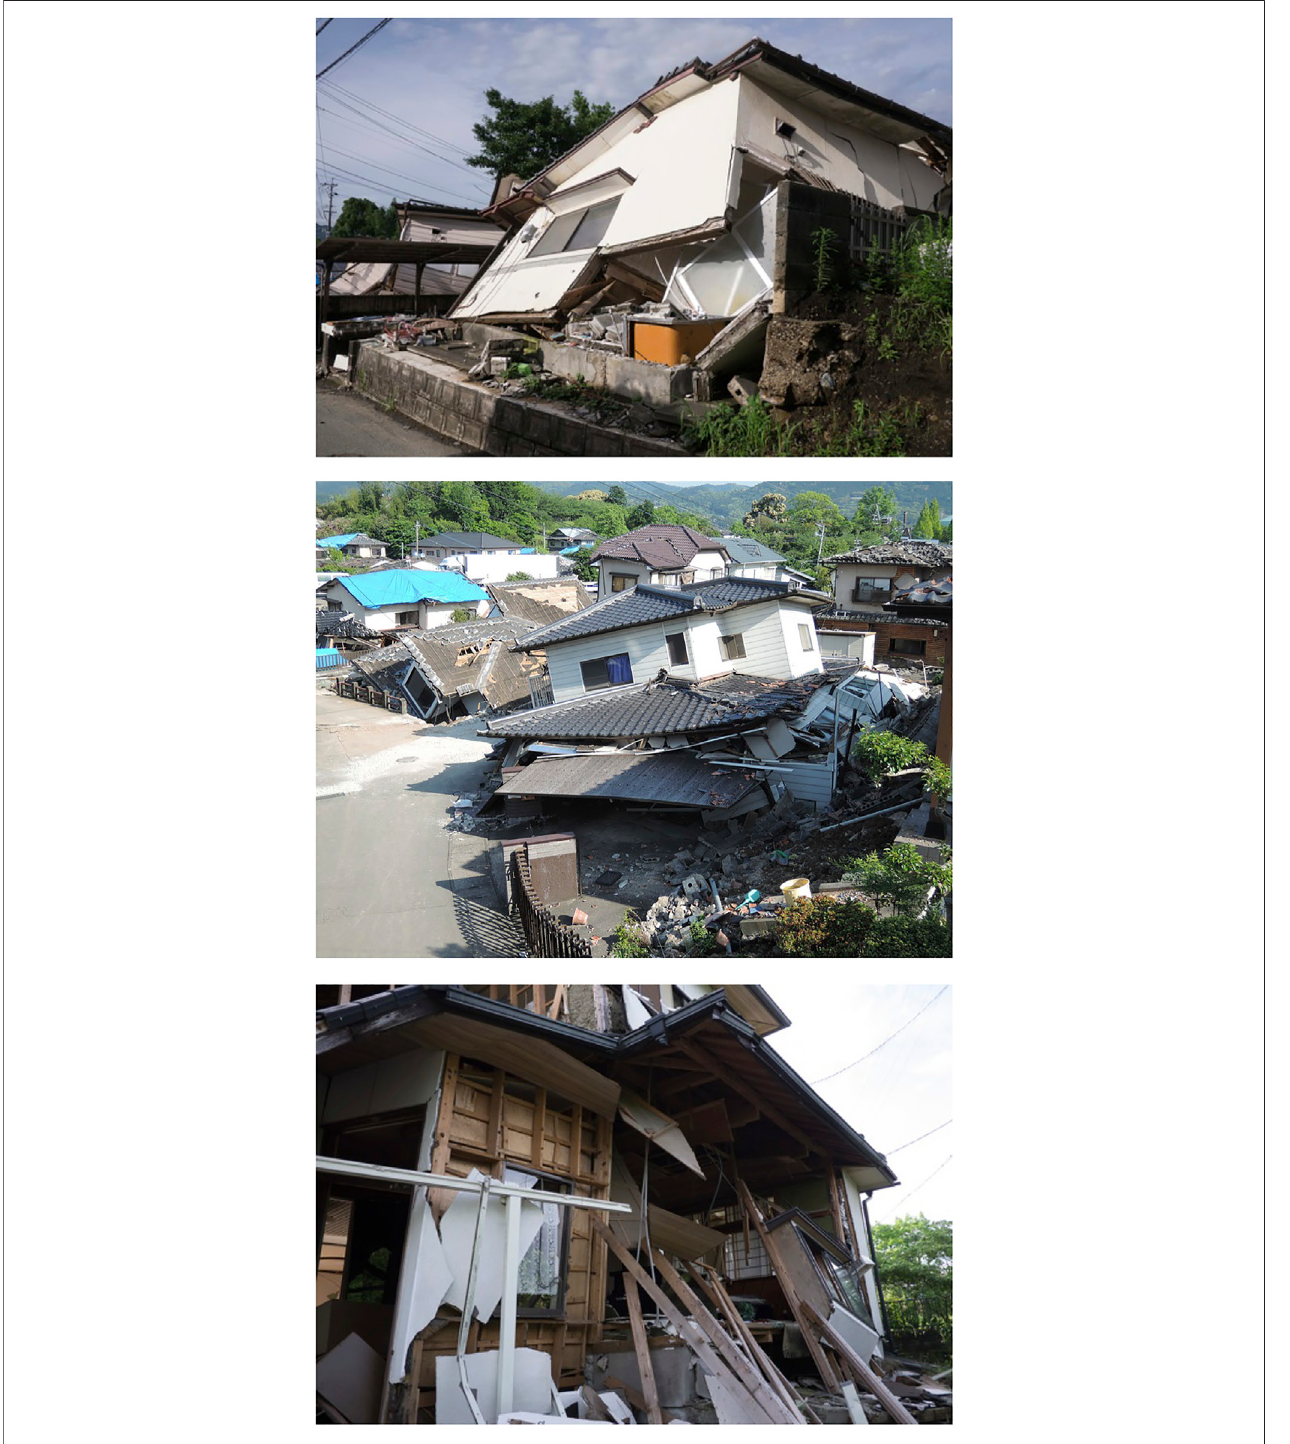
FIGURE 3 | Damage of timber frame houses by the 2016 Kumamoto Earthquake.